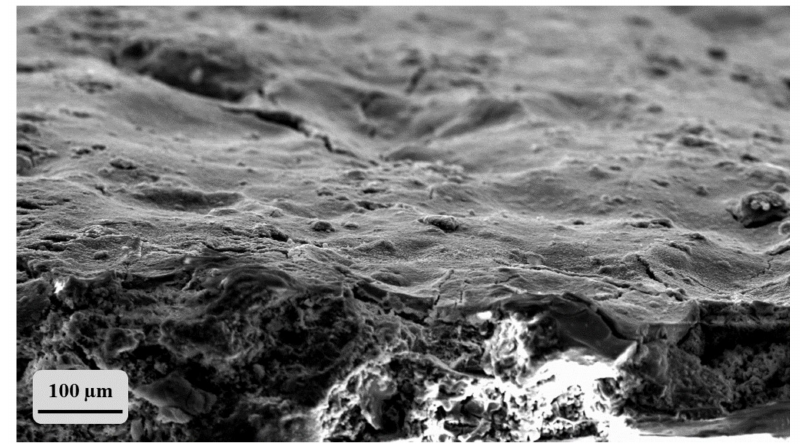
Figure 6. SEM image of CI after brushing treatment with pure LS.